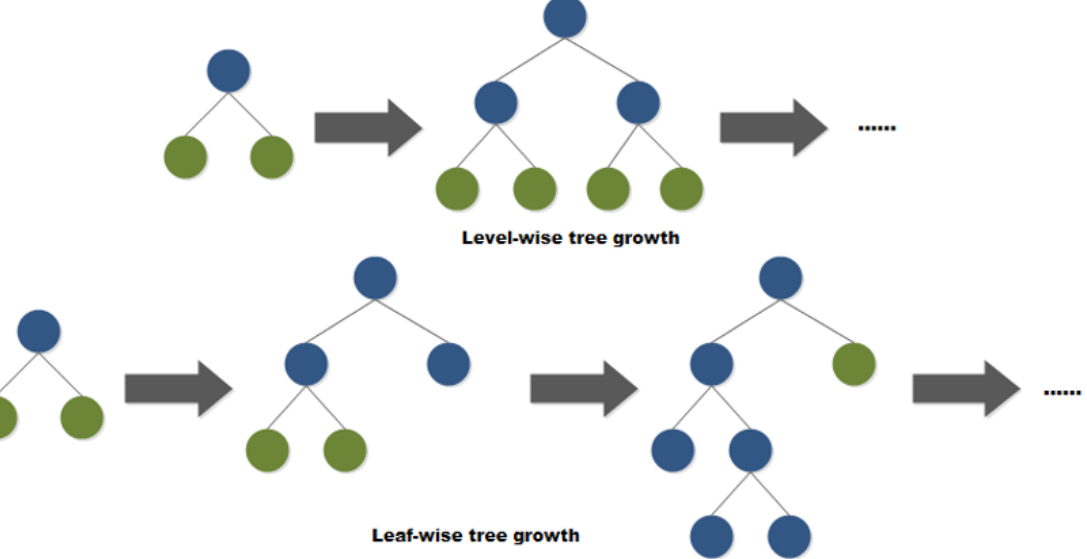
Figure 4. Comparison of Leaf-wise and Level-wise growth strategies. Extreme Gradient Boosting (XGBoost)